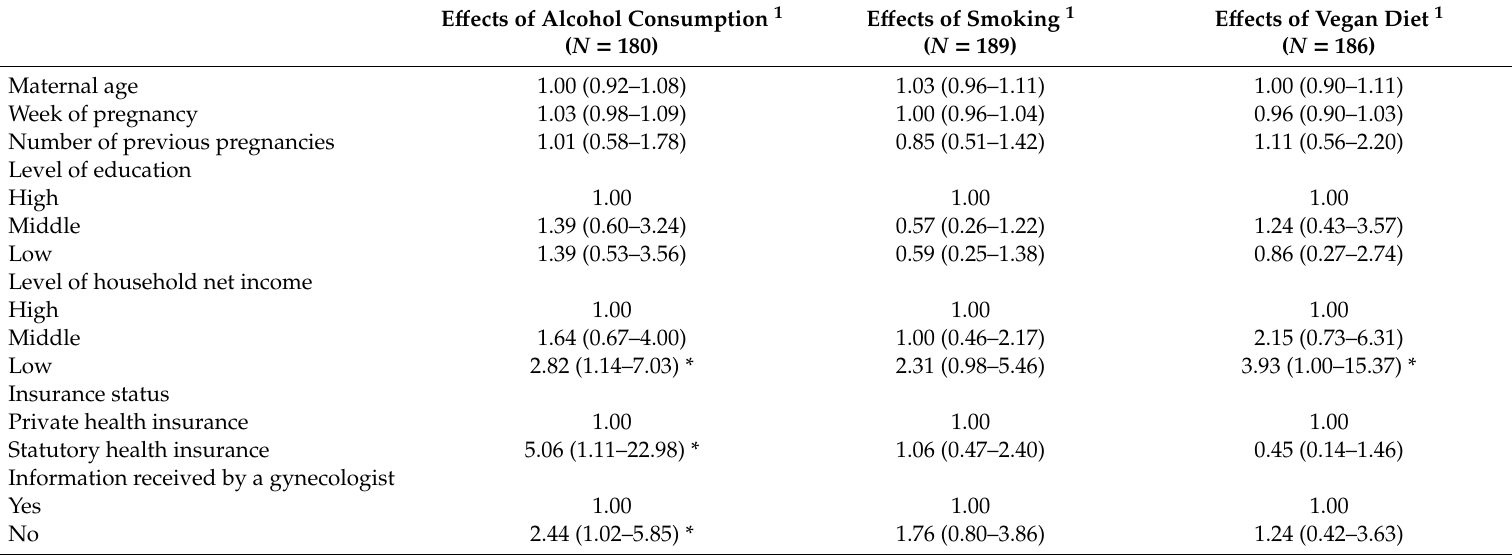
Table 5. Risk of non-compliant knowledge of the health e ff ects of alcohol consumption, smoking, and a vegan diet during pregnancy in association with independent variables, expressed in odds ratios (95% confidence